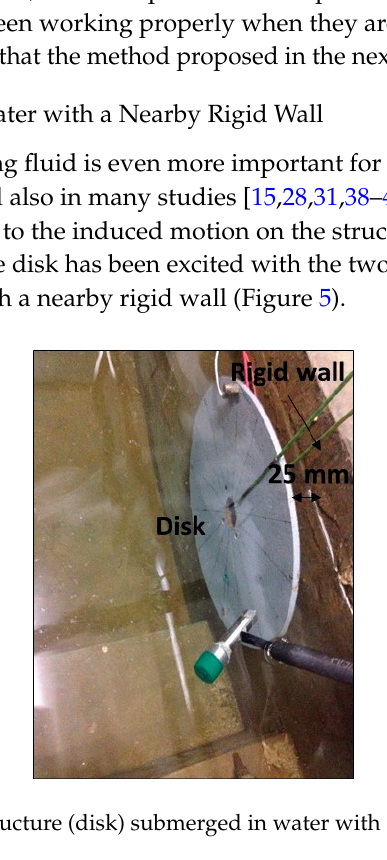
Figure 4. Sweep excitation (PZT): excitation and response.